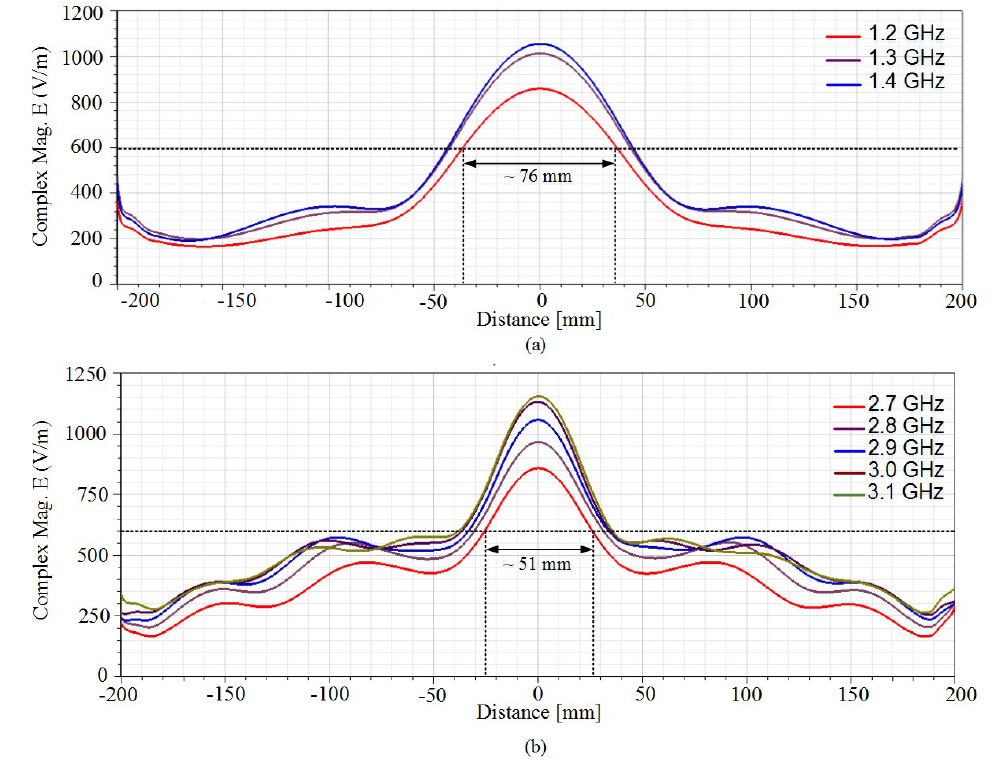
Figure 7. Simulated E-field intensity on the metal surface at the center cross section of the steel plate with input power of 12 W ( a ) L-probe antenna for 1.2–1.4 GHz range (1st E-probe); and ( b ) L-probe antenna for 2.7–3.1 GHz range (2nd